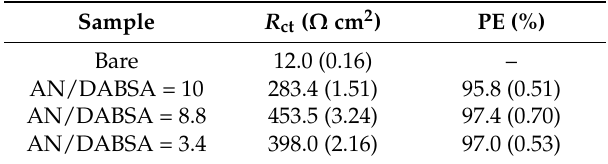
Table 1. Charge transfer resistance ( R ct ) derived from EIS measurements (Figure 9) and the protection efficiency (PE) of bare and SPAN-deposited mild steels with different AN/DABSA ratios in 1 M HCl.